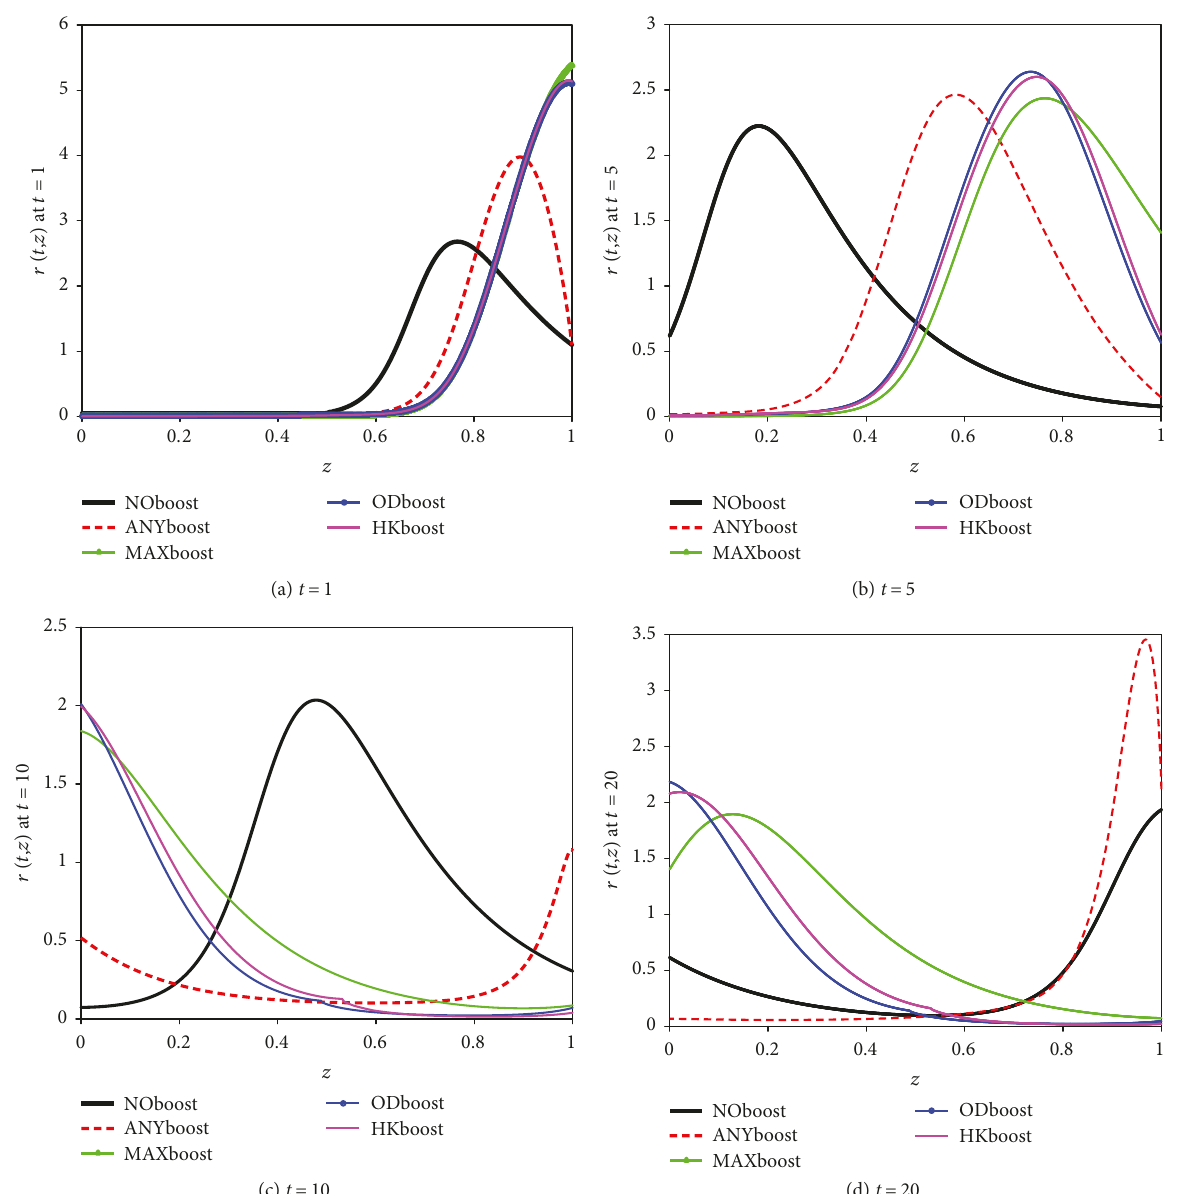
Figure 7: Comparison of the e ff ects of di ff erent boosting mechanisms on the distribution of immunity r t ∗ , z at fi xed times t ∗ = 1, 5, 10, 20 years after the beginning of the observations.